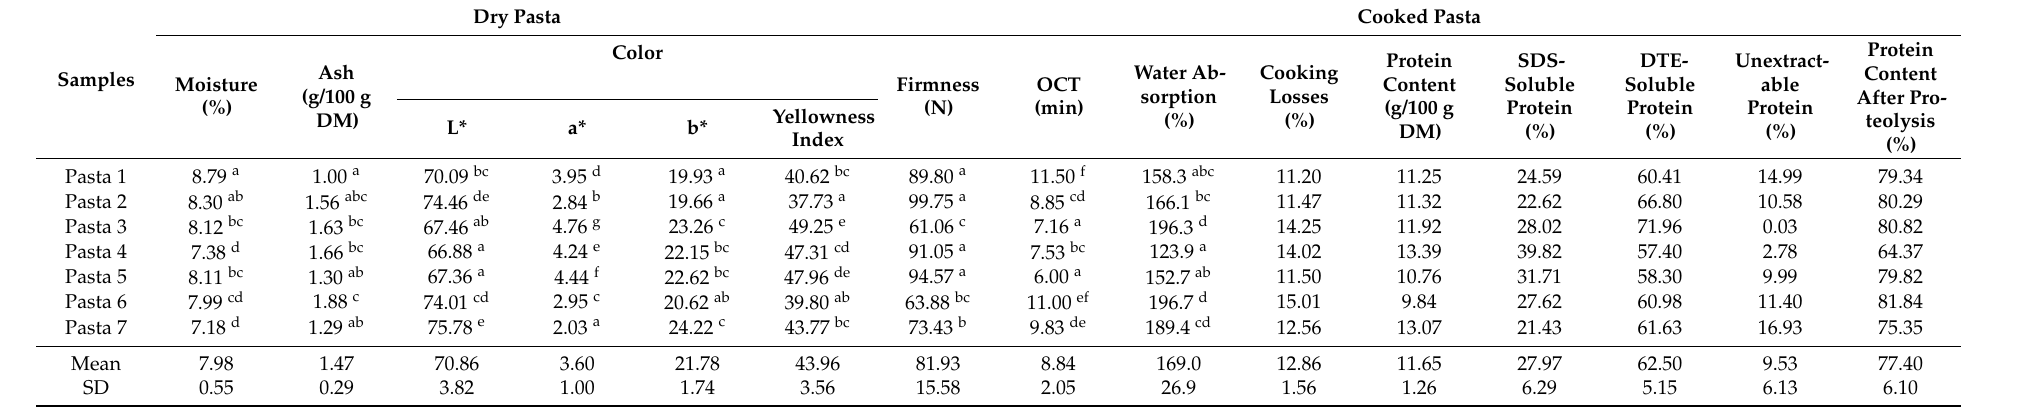
Table 2. Main characteristics of the dry and cooked